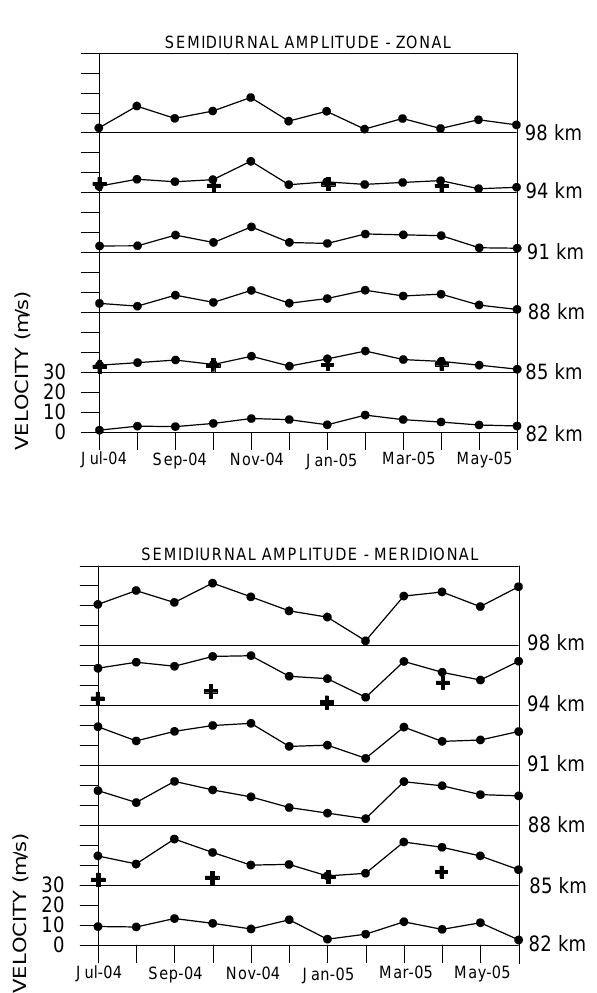
Fig. 9. Zonal (a) and Meridional (b) amplitude of 12-hour tide. Each horizontal line represents the value 0 (zero) at the respective height. The symbol ( + ) represents the amplitude calculated by the model GSWM at 82 and 94 km .